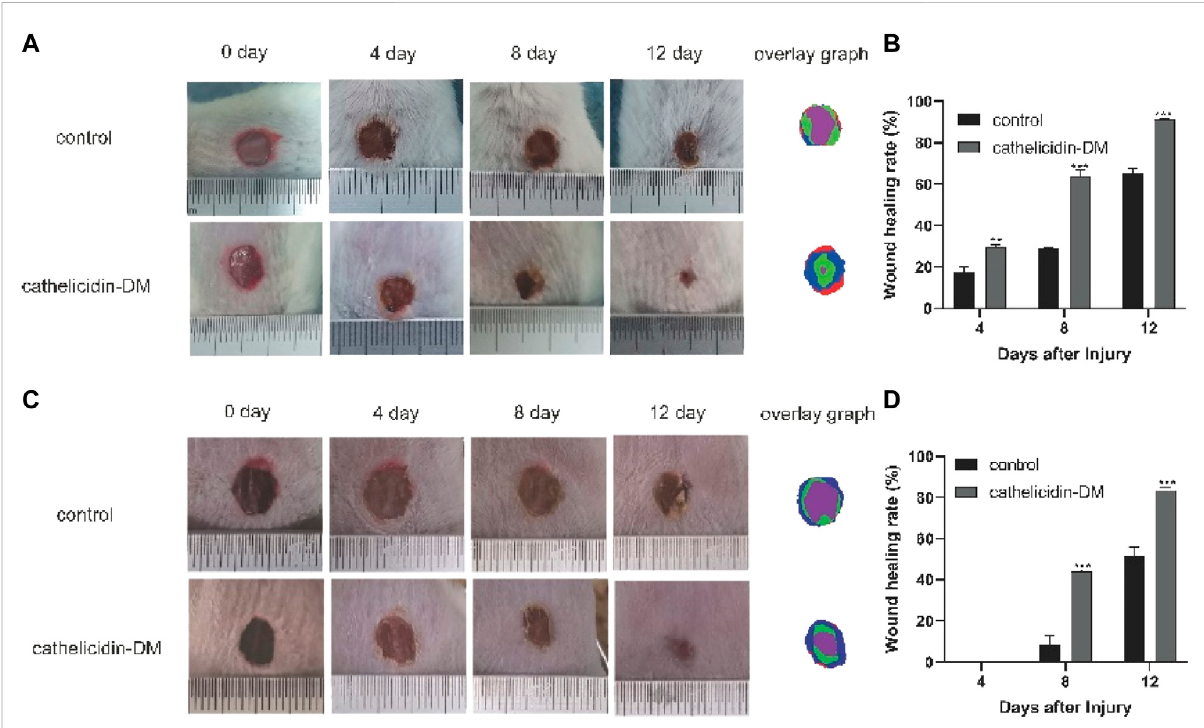
FIGURE 4 Cathelicidin-DM treatment accelerates wound closure in balb/c mice. (A) Graph of the healing effect of mouse trauma models treated with cathelicidin-DM, PBS on days 0, 4, 8, and 12 after trauma and superimposed maps of wound tissues from mice at 0, 4, 8, and 12 d processed by Photoshop, with red, blue, green and purple representing wound tissues from mice at 0, 4, 8 and 12 d post-trauma, correspondingly. (B,D) Quantitative analysis of wounds using ImageJ software and calculation of wound healing rates in the control and cathelicidin-DM groups. (C) Healing effects and wound overlays of a mouse S. aureus-infected wound model treated with cathelicidin-DM, PBS on days 0, 4, 8, and 12 post- wound. The value is shown as mean ± standard, * p < 0.05, ** p <